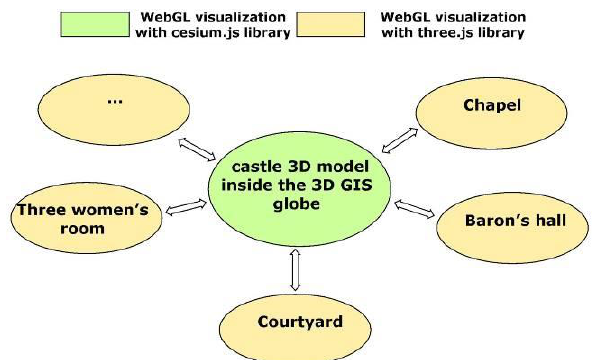
Figure 10. The structure of the open-source WebGL-based